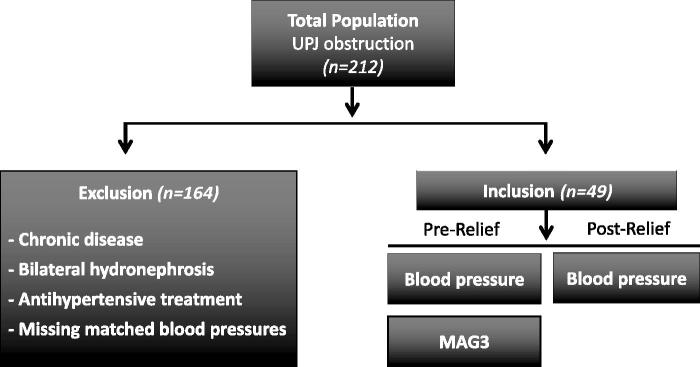
Schematic illustration of the study diagram. Medical records and hospital charts of 218 patients who were operated (2000–2016 at the Urology Department of Uppsala University Hospital) due to hydronephrosis were studied. A total of 212 patients displayed hydronephrosis due to ureteropelvic junction (UPJ) obstruction. Patients with other chronic disorders, bilateral hydronephrosis, antihypertensive treatment, or with missing data on blood pressure (i.e. before or after surgical management) were not included in the analysis. From the total population with operated UPJ obstruction 49 patients fulfilled the inclusion criteria, and their systolic, diastolic, and mean arterial pressure were analyzed before and after surgery, and linear regression analysis was carried out comparing changes in arterial pressure with renal function by mercaptoacetyltriglycine (MAG3) renography.